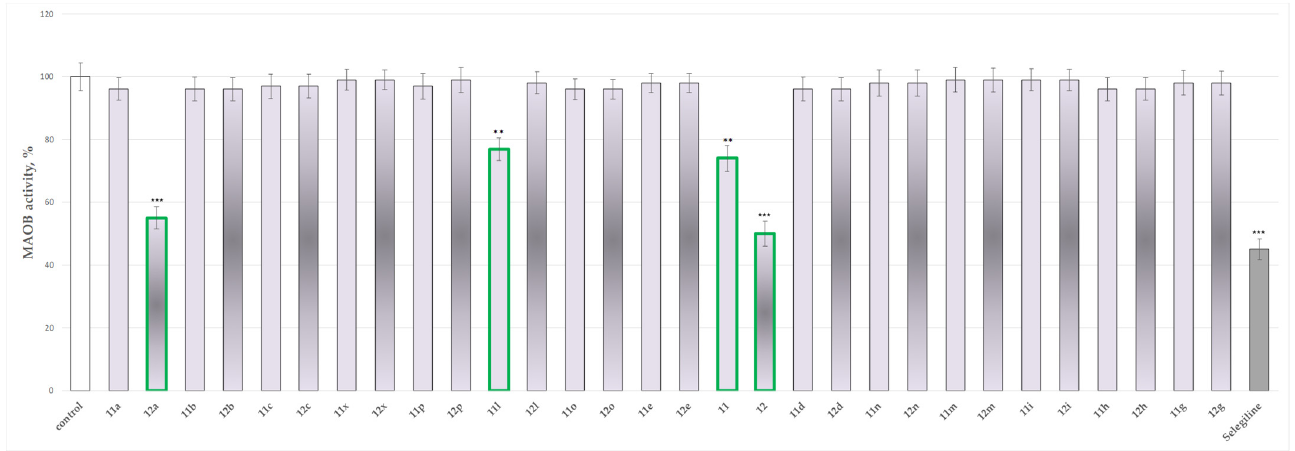
Figure 12. Effects of compounds 11 , 11a – 11x, 12, 12a – 12x and Selegiline in 1 μ mol concentration, applied alone, on the h MAOB activity. ** p < 0.01, *** p < 0.001 against the control (pure h MAOB).